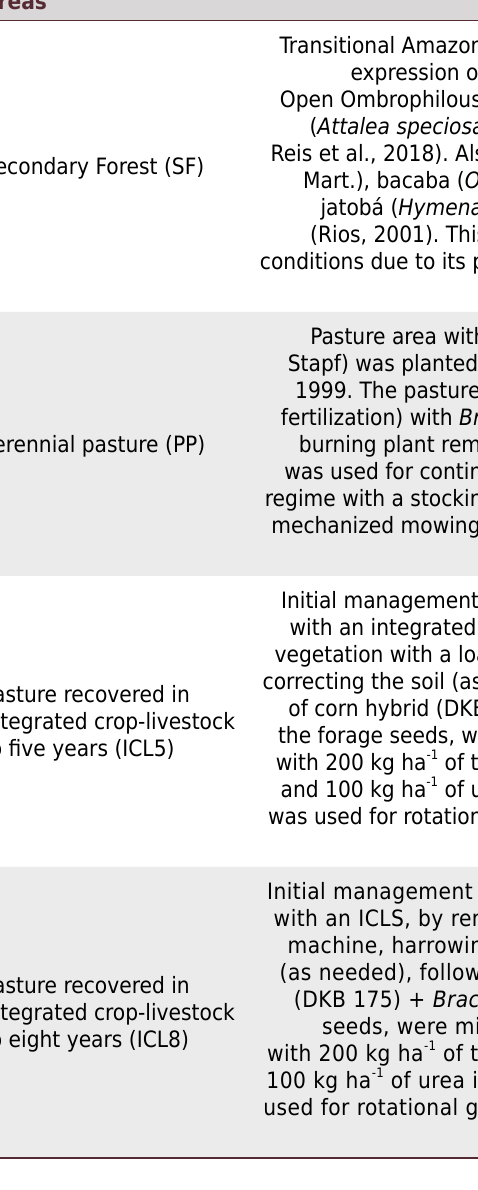
Table 2. History and characteristics of the management models studied in the technology reference unit in the Pindaré-Mirim region, Maranhão, Brazil Areas Area